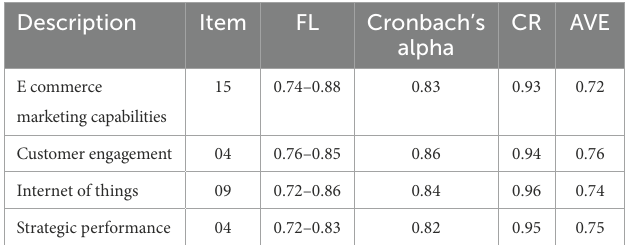
TABLE 1 Validation and reliability.